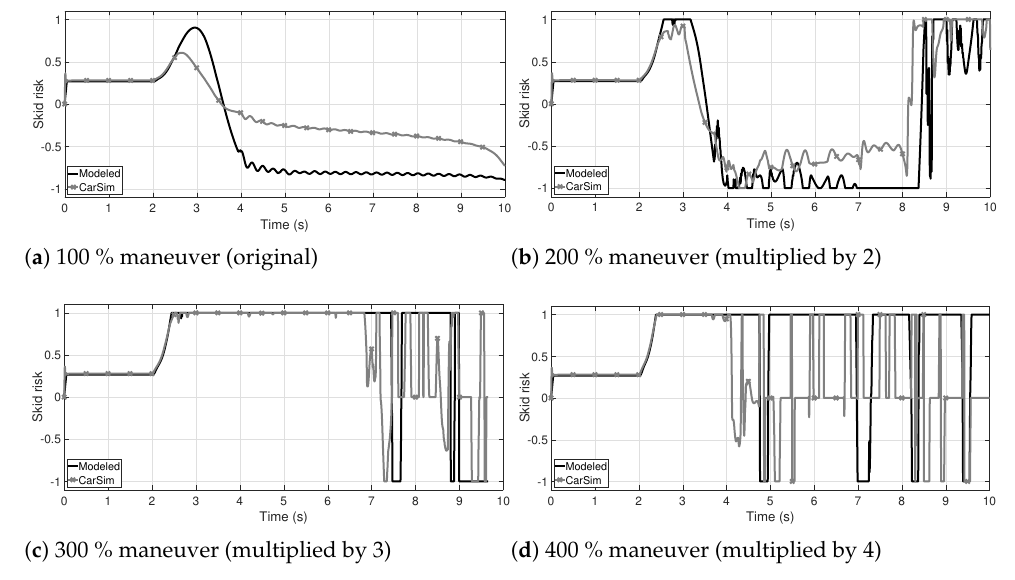
Figure 6. Comparison of the skid risk ( SI ) modeled in this paper, and calculated by the vertical forces provided by CarSim, using the maneuver of Figure 2a multiplied by 100, 200, 300 and 400%. Rear tracking force (accelerating on both wheels) of 150 N , with µ = 0.5 are used to induce the skid with aggressive maneuvers. The model presented in this paper is enough precise to detect an imminent skid. Only the 100% maneuver can be performed without a skid; even with the 200% maneuver, the TWV skids and eventually suffers a tripped rollover (skid and